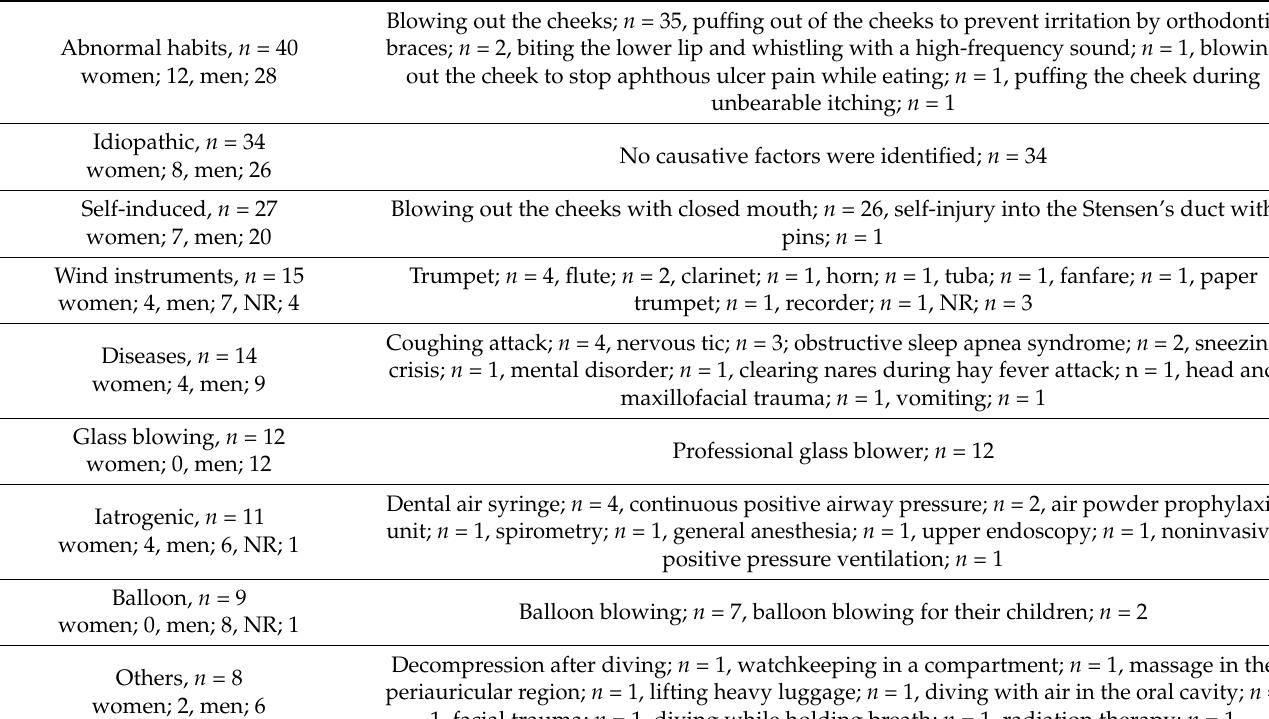
Table 2. Causes for each etiology. NR; not